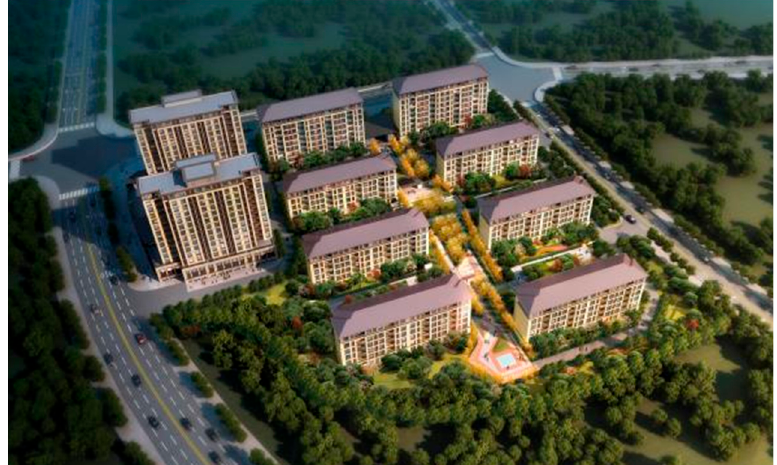
Figure 3. Planning diagram of the relocation project of a company.